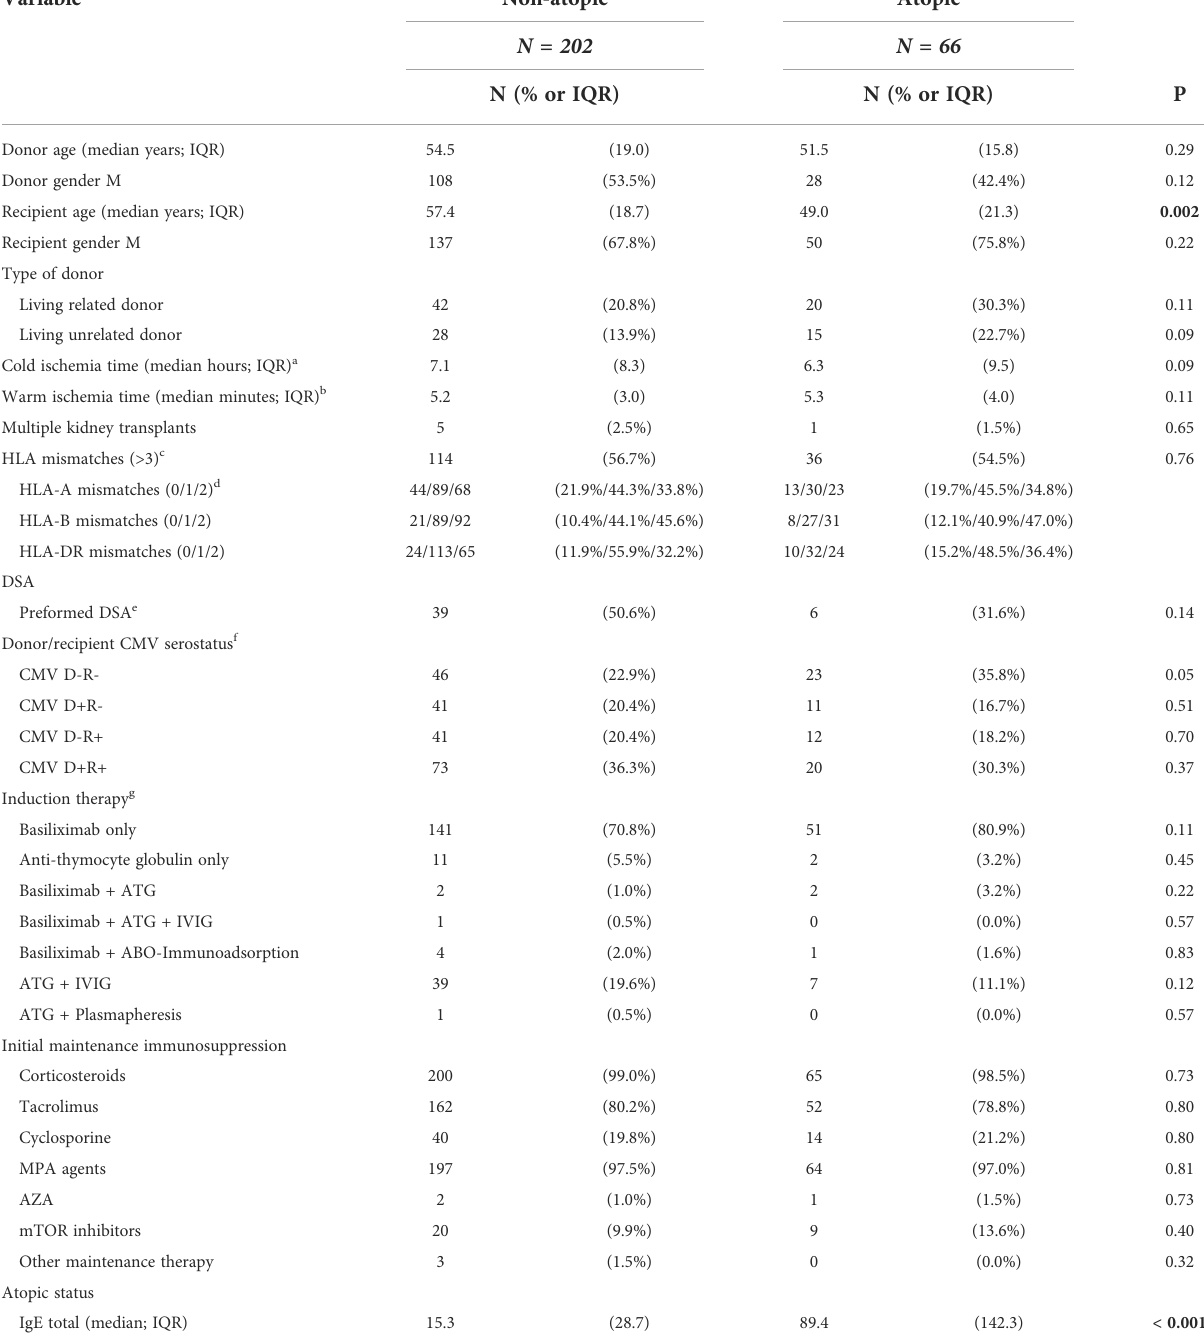
TABLE 1 Characteristics of non-atopic and atopic kidney transplant recipients at the time of transplantation.